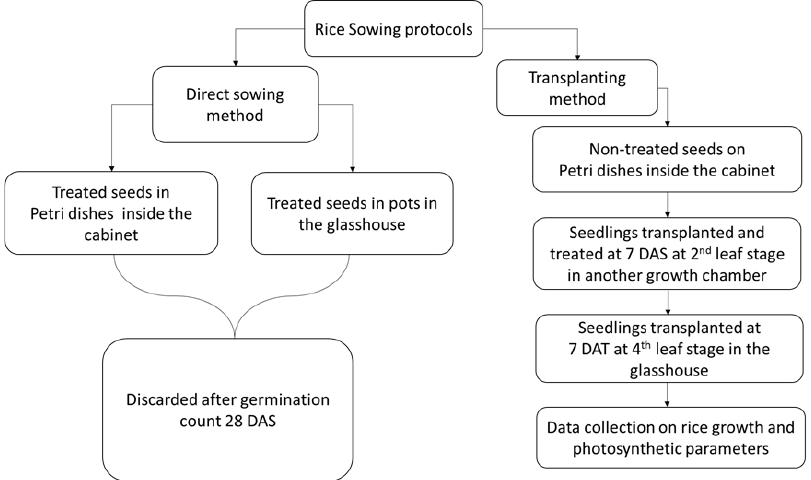
Figure 1. Different rice germination protocols for the experiments.